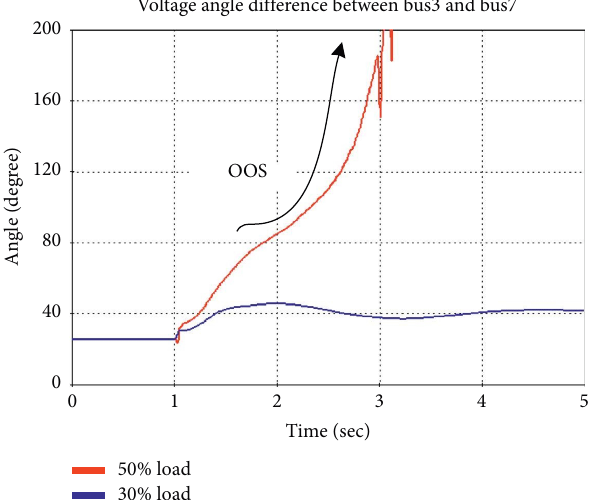
Figure 14: Voltage angle diference between bus 3 and bus 7 in cases of 30% and 50% loading increase.